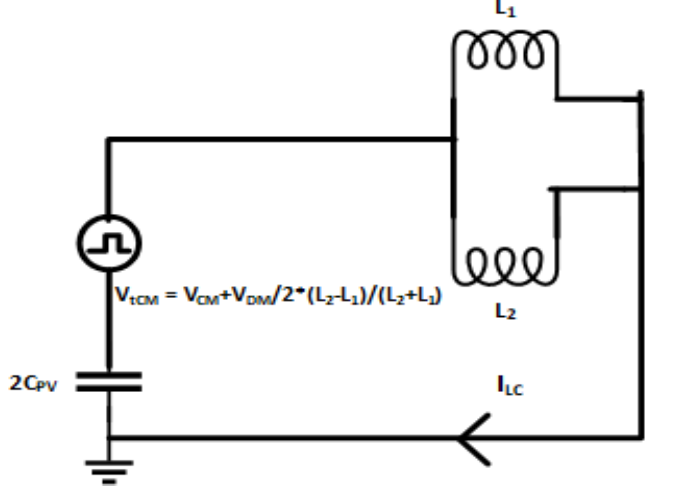
Figure 5. Final common mode model of single-phase grid-connected PV with transformerless in- verter.